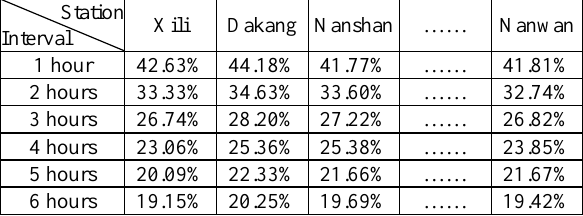
Table 3.TS scores of 2hours time scale SVM for future different hours rainfall prediction